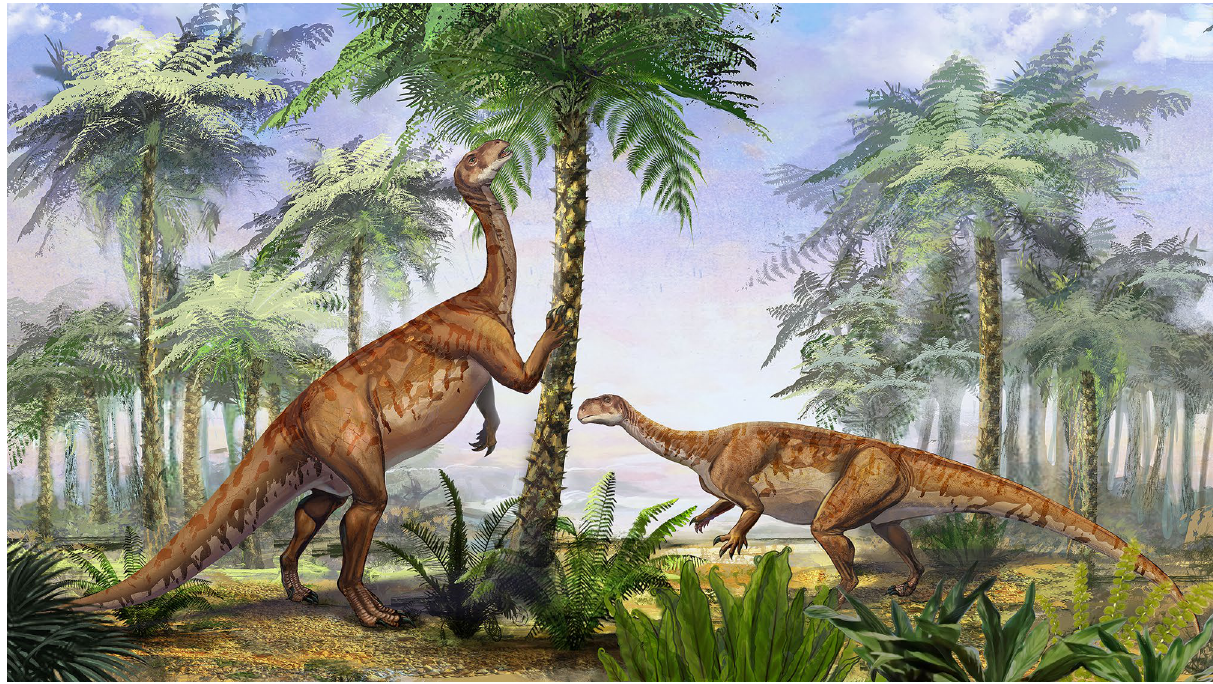
Figure 13. Irisosaurus yimenensis life reconstruction, by Ang